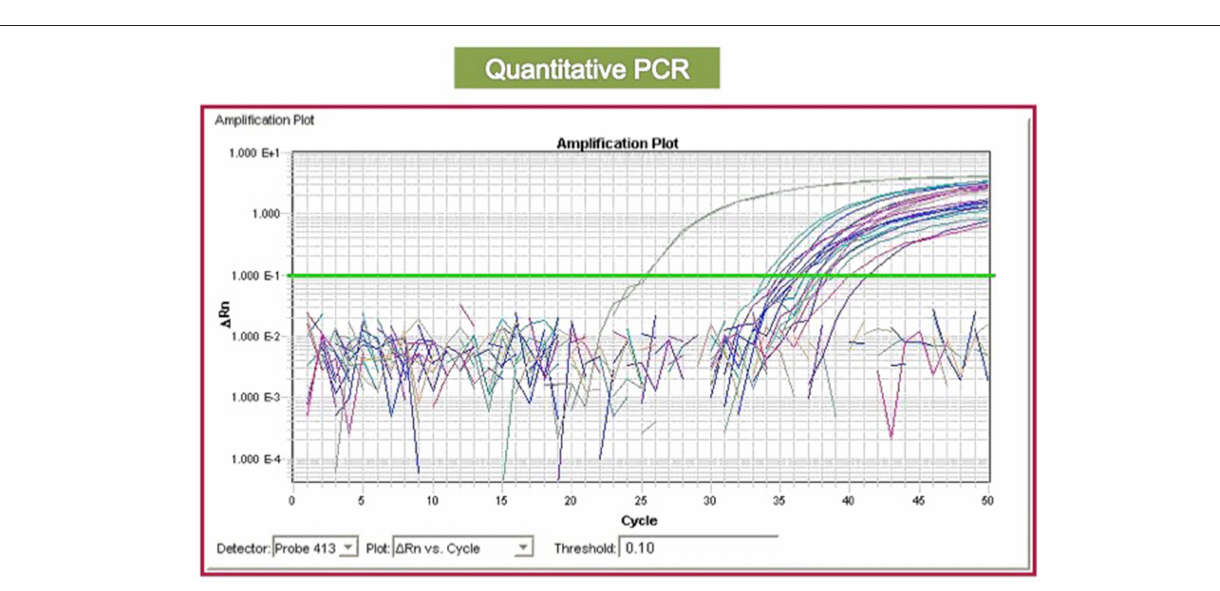
FIGURE 2 | Quantitative PCR plot (RQ-PCR): the real-time amplification allows to measure the quantity of BCR-ABL1 transcript by using a reference curve. By the measure of the threshold cycle (the cycle corresponding to the point where the amplification signal overcomes the background) is possible to calculate the concentration of each